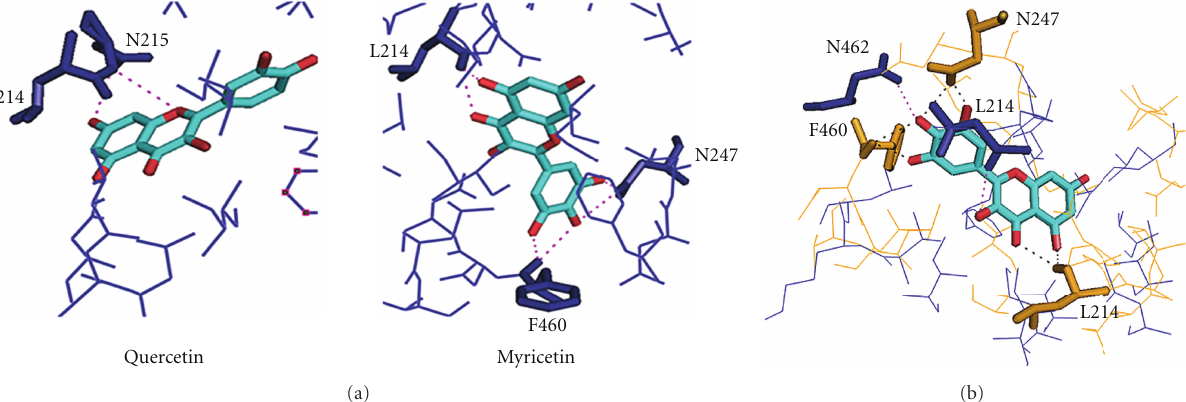
Figure 9: (a) The binding pose of Kp DnaB to Myr is di ff erent from that of Que. Que interacts with L214 and N215, whereas Myr interacts with L214, N247, and F460. (b) Myr was docked in di ff erent positions of the ATP-binding pocket of both DNA-unbound and DNA-bound models of Kp DnaB. Myr interacts with L214, N247, and F460 in the DNA-unbound model, and interacts with L214 and N462 in the DNA- bound model of Kp DnaB,